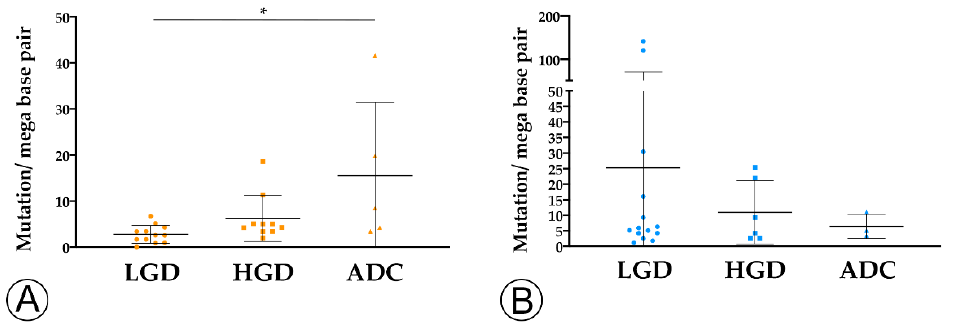
Figure 4. TMB analysis along the colorectal adenoma-carcinoma in sporadic ( A ) and hereditary Familial Adenomatous Polyposis (FAP)-related ( B ) lesions. * = p < 0.05. LGD, low-grade dysplasia (circles); HGD, high-grade dysplasia (squares); ADC, invasive adenocarcinoma (triangles); * = p < 0.05.